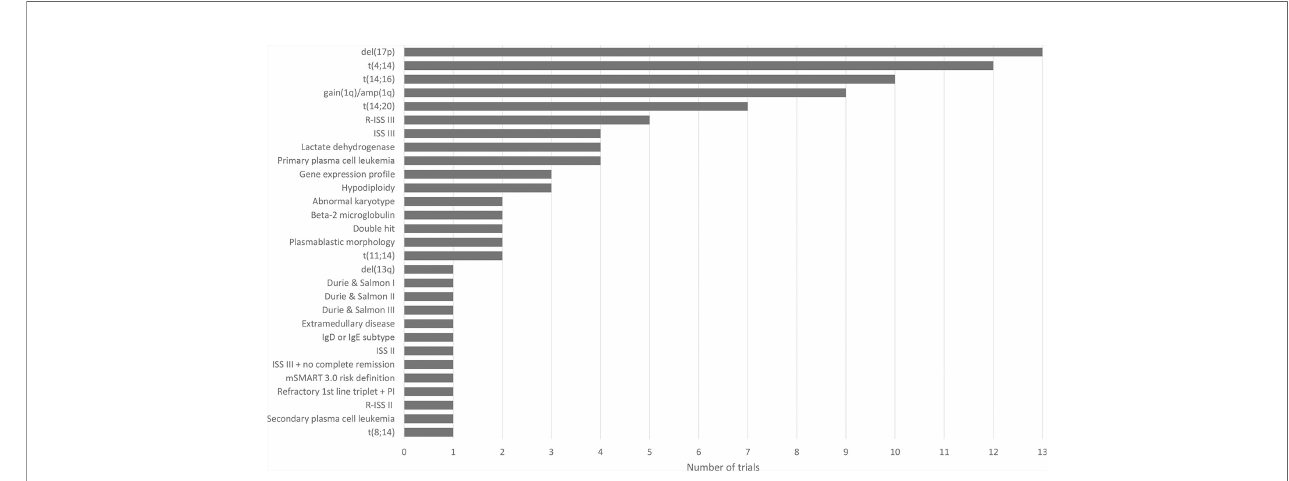
FIGURE 1 | Overview of 29 high-risk markers for multiple myeloma resulting from the analysis of 17 clinical trials (NCT00570180, NCT00691704, NCT00793572, NCT01341262, NCT01668719, NCT02217163, NCT02685826, NCT03004287, NCT03104842 (GMMG-CONCEPT), NCT03188172 (OPTIMUM), NCT03441958,